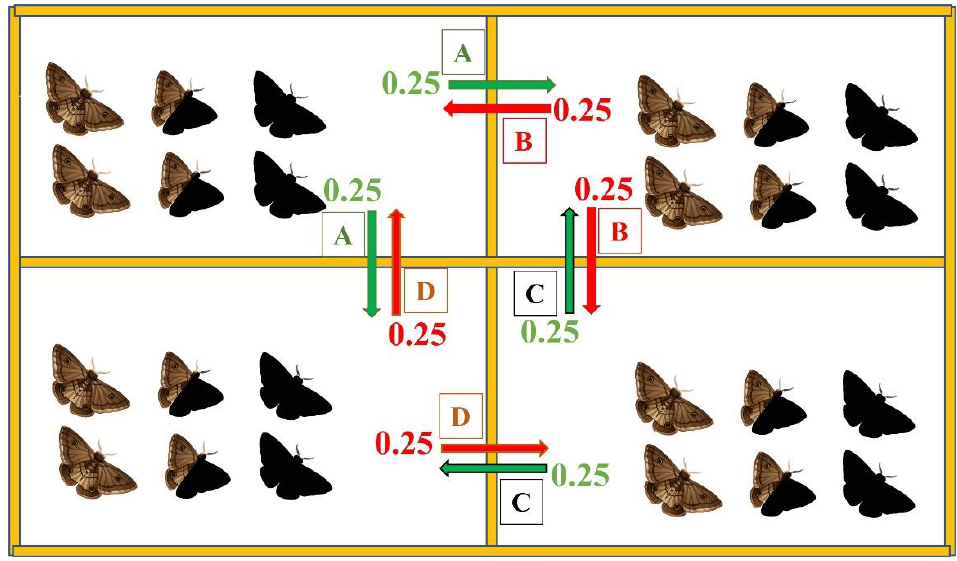
Figure 2. Representation of the movement of Helicoverpa armigera or Spodoptera frugiperda adults by generation in the cellular automata. The permanence and migration rates for each neighboring quadrant of adults in each quadrant were 0.50 and 0.25, respectively. Moths with black wings represent an insecticide-resistant strain; moths with brown and black wings represent a heterozygous strain; moths with brown wings represent an insecticide-susceptible strain. Green arrows indicate emigration, while red arrows indicate immigration.